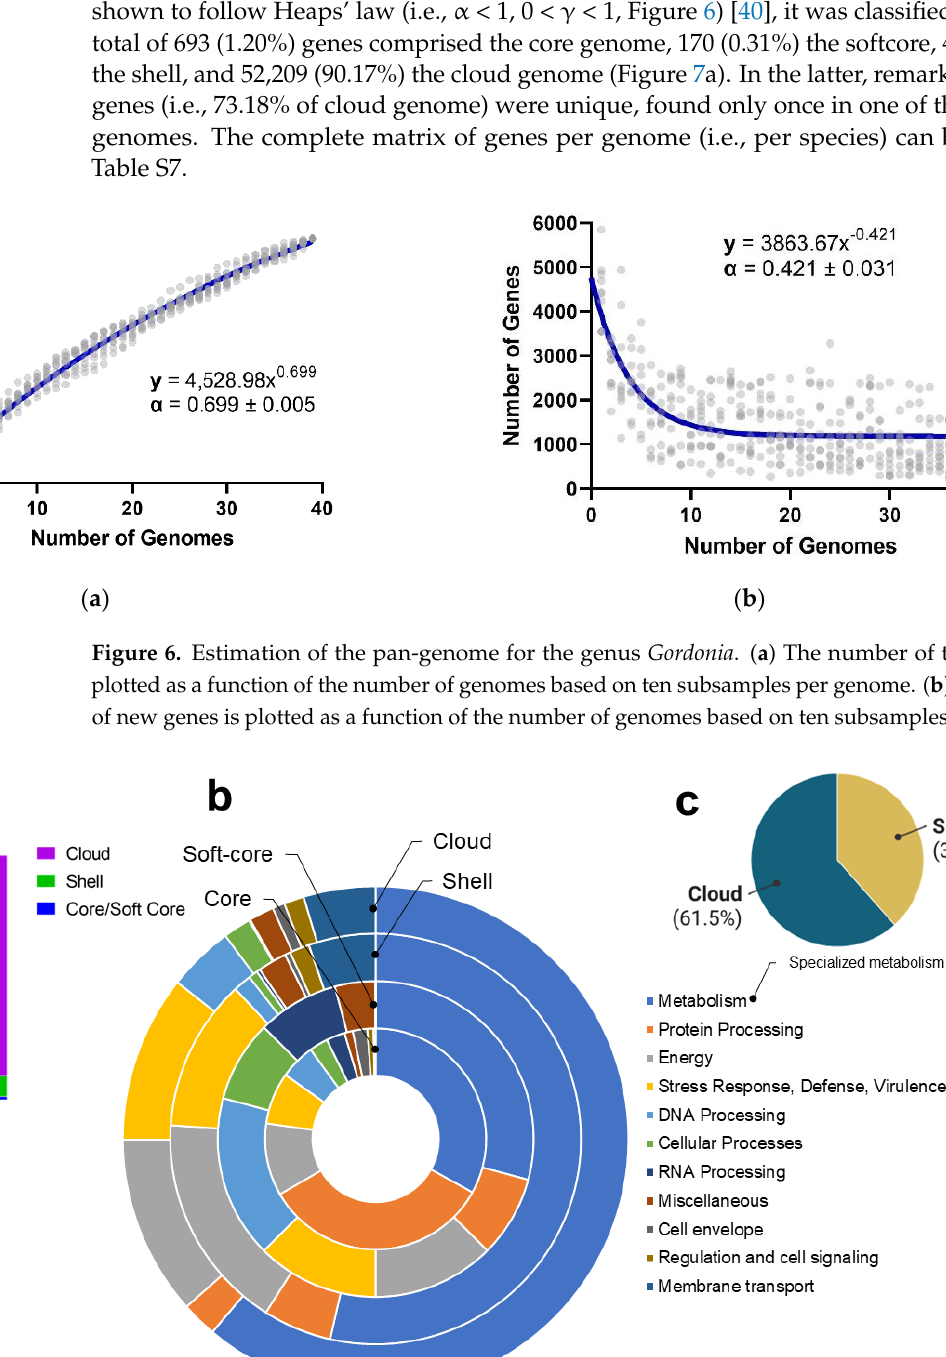
Figure 7. Overview of the assignments to functional subsystems of the Gordonia pan-genome. ( a ) Distribution of genes in core/softcore, shell, and cloud genomes. ( b ) Doughnut plot of the functional assignment of genes in the core, softcore, shell, and cloud genome (from the inner to the outer ring, respectively). ( c ) Pie chart of the distribution of genes assigned to specialized metabolism in core and shell genomes (no genes were found within core and softcore genomes).